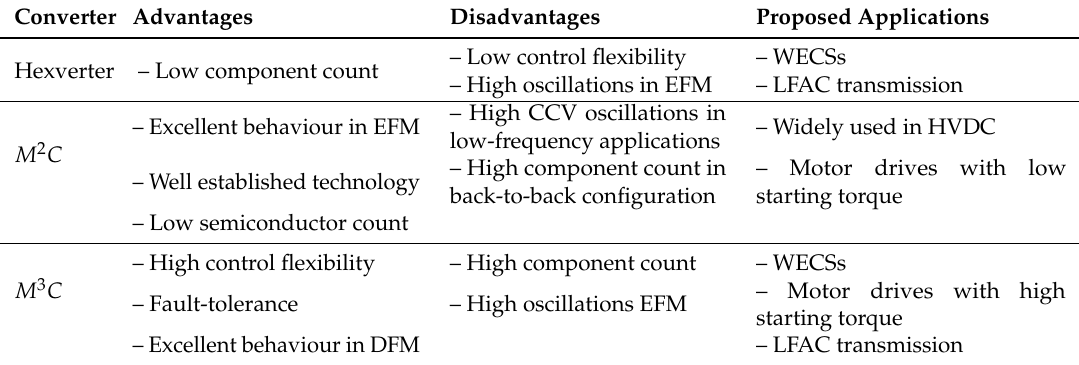
Table 3. Advantages and disadvantages of the MMCC topologies compared in this